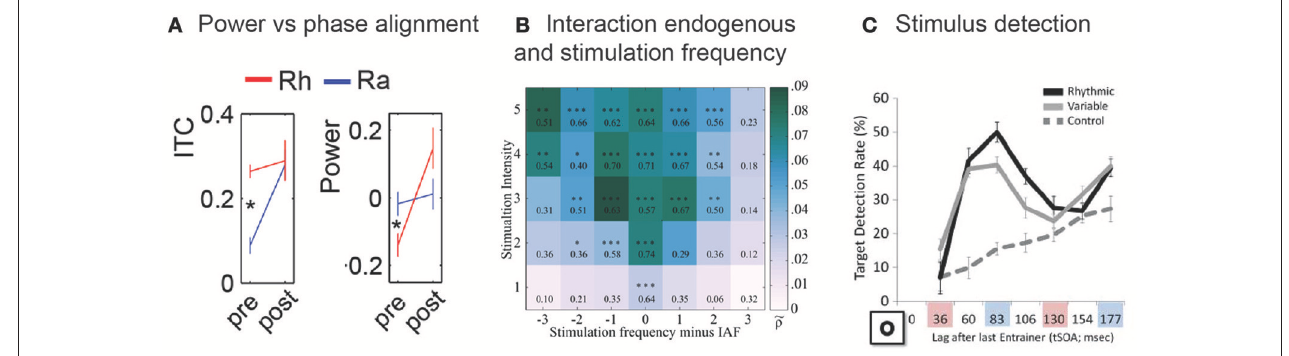
FIGURE 3 | Overview of selected studies providing evidence from signal properties and cognitive effects that are expected to differ between endogenous oscillatory activity and regular evoked responses. (A) ten Oever et al. (2017) reported higher inter-trial coherence (ITC) for rhythmic (Rh) compared random (Ra) auditory subthreshold stimuli stream (sub-threshold trials are denoted “pre”; supra-threshold trials are denoted “post”). The higher ITC was paralleled with lower power values for the rhythmic compared to the random subthreshold sounds. Asterisks indicate a significant difference ( p < 0.05) between rhythmic and random conditions. (B) The intensity required for a rhythmic stimulus to “entrain” an endogenous oscillation depends on the distance between the stimulus frequency and the natural frequency of the oscillator. This relationship results in a triangular shape representing the dependence of entrainment strength on frequency and intensity of the entraining stimulus, the so-called Arnold Tongue. Notbohm et al. (2016) reported that the EEG signal in response to a rhythmic visual stimulus follows the characteristics of an Arnold Tongue, if it is analyzed based on participants’ individual alpha frequency (IAF). Reproduced with permission from Notbohm et al. (2016). (C) Mathewson et al. (2012) measured the probability of detecting a visual target at different time lags after the offset of a rhythmic visual stimulus ( ∼ 12Hz). They found a periodic modulation of perception (i.e., target detection); these aftereffects were also present when a certain jitter was introduced in the rhythm, but not after the presentation of two visual stimuli separated by a certain time interval (576ms) but without any rhythmic component (control). Reproduced with permission from Mathewson et al.